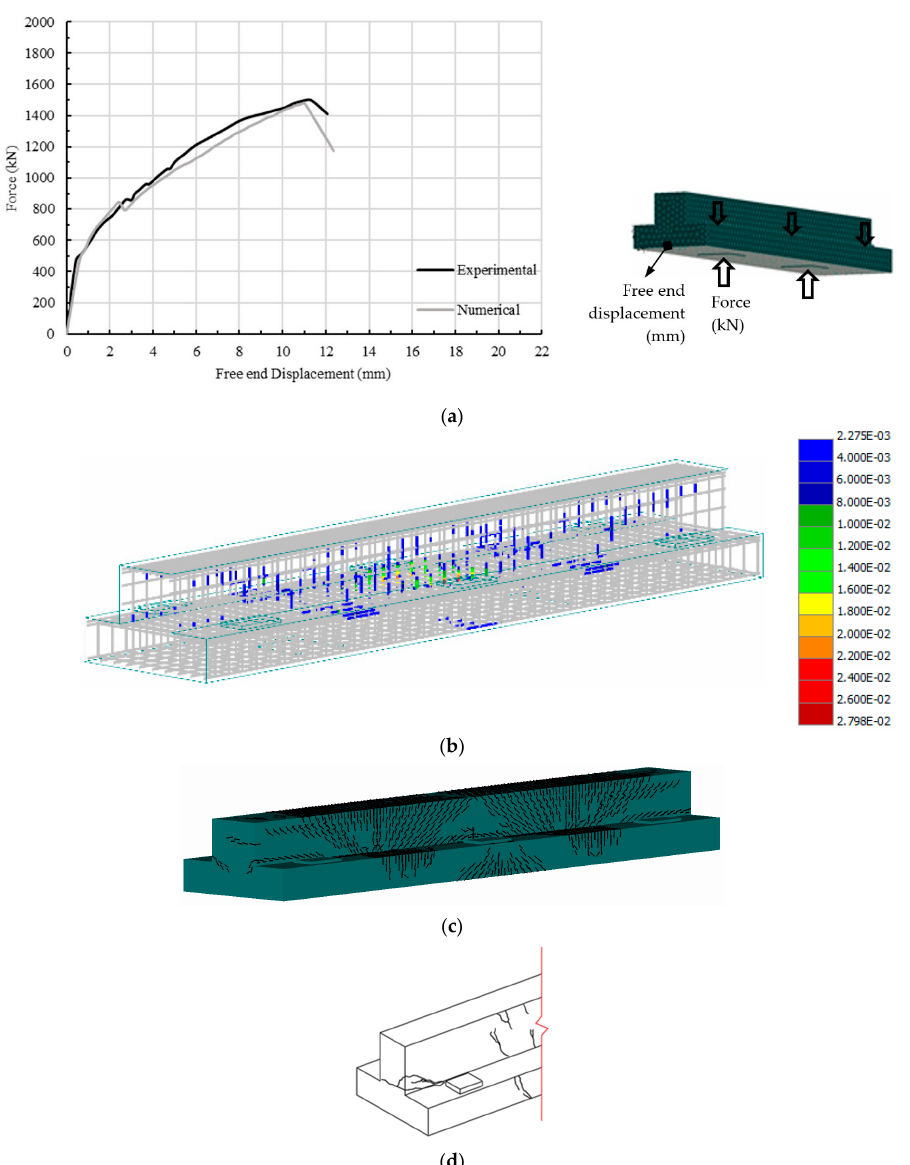
Figure 7. Experimental and numerical responses of specimen ITBC-0-T-2M (0° skew): ( a ) Experimental and numerical force-displacement curves; ( b ) Yielded reinforcements; ( c ) Crack patterns; ( d ) Test crack pattern [14]. The numerical model was further validated with test results of the 30° skewed spec- imen ITBC-30-S-2M. The experimental and numerically predicted force-displacement be- havior of specimen ITBC-30-S-2M are presented in Figure 8a and it can be seen that they are in good agreement. The stiffness of the numerical model in the pre-cracking stage was